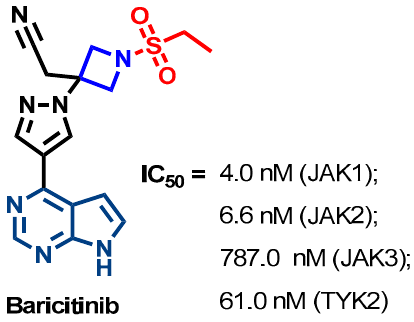
Figure 17. JAKs inhibitory activities of baricitinib.